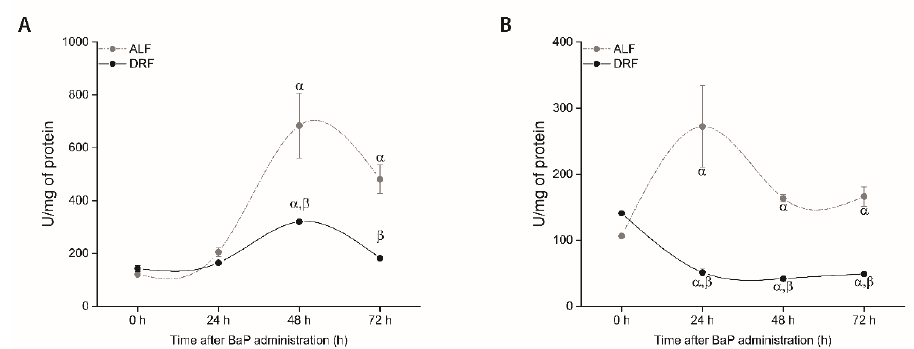
Figure 4. Activities of AST ( A ) and ALT ( B ) in the blood of rats with ALF (gray circles) and DRF (black circles) after BaP administration at 10 mg/kg. Each point corresponds to the mean ± SEM, n = 6. α p ≤ 0.05 compared to the control group fed with the same diet (DRF at ZT1 and ALF at ZT13) and β p ≤ 0.05 compared to the ALF group at the same time points.